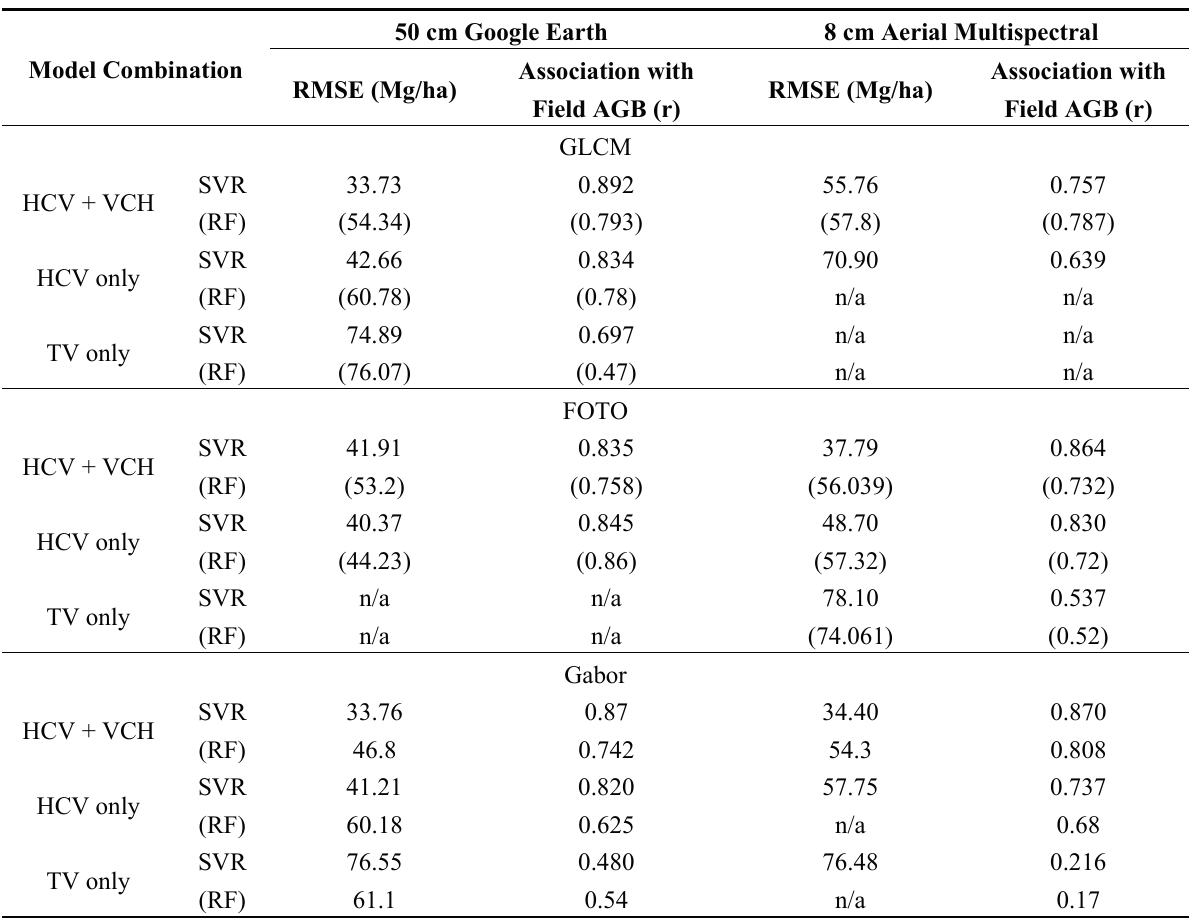
Table 1. Summary of the different method and model combinations used in AGB prediction. RF, random